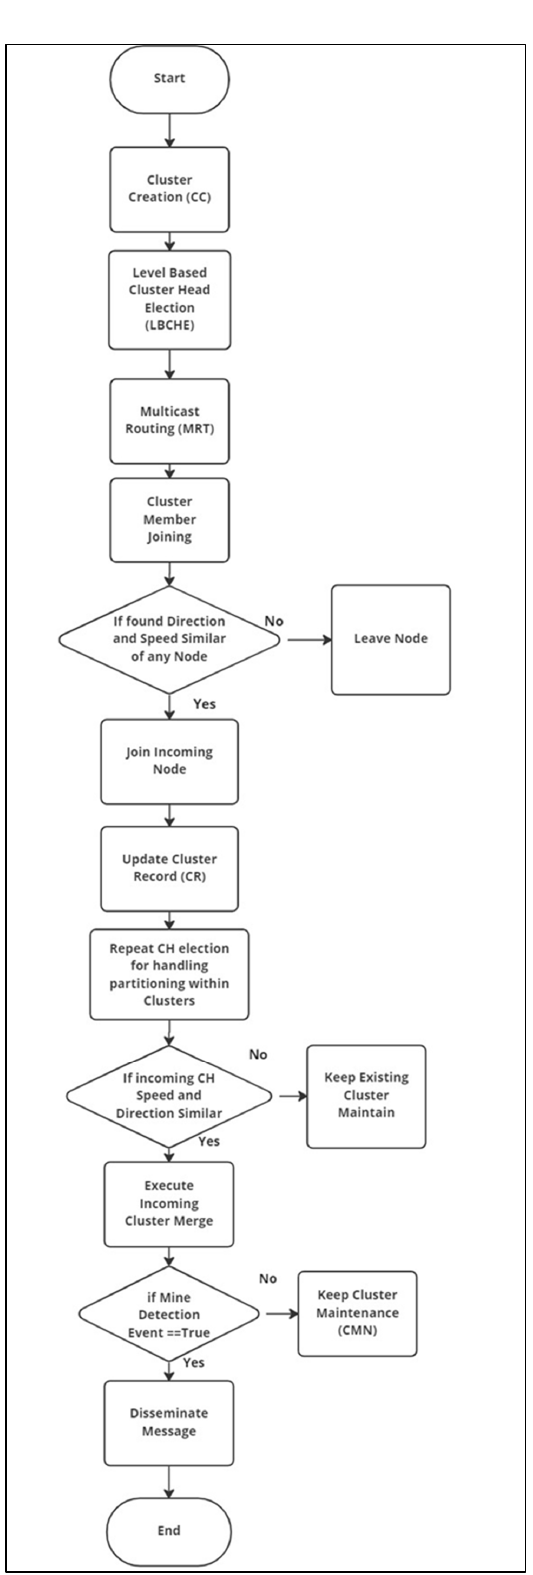
Figure 3. Flowchart of UGAVs-MDVR